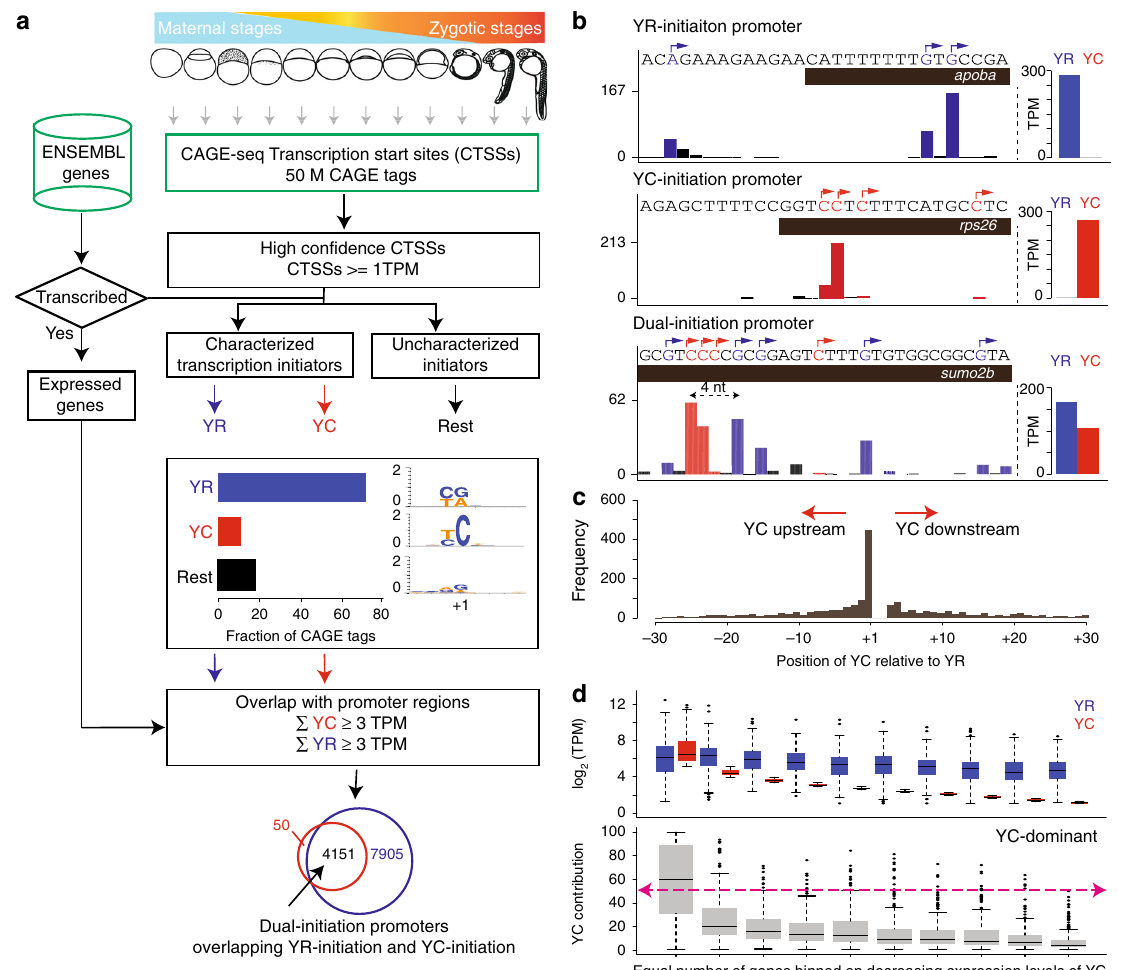
Fig. 1 Intertwined canonical initiator (YR) and non-canonical initiator YC (alias as TCT/5 ’ TOP) within the same core promoter. a A systematic pipeline for identi fi cation of canonical (YR) and non-canonical (YC) initiators in the zebra fi sh developmental promoterome. CTSSs are classi fi ed into YR and YC initiators based on CAGE transcription start sites (CTSSs). b UCSC browser views with CAGE data from prim 5 stage to illustrate examples of YR-initiation ( apoba ) and YC-initiation ( rps26 ) promoters along with a gene promoter with intertwined YR-initiations and YC-initiations ( sumo2b ). YR-initiations and YC- initiations are shown in blue and red colors respectively. Barplot on the right shows the sum of expression levels of YR-initiations and YC-initiations. Highest CTSS represents the dominant transcription start site. The distance between dominant YR and YC in sumo2b is four nucleotides. c Frequency of position of dominant YC-initiation relative to dominant YR-initiation in dual-initiation promoters. d Contribution of YC-initiation with respect to YR- initiation expression levels in prim 5 stage. The 4151 genes with dual-initiation are sorted according to YC expression levels and grouped into 10% bins. Expression levels (top) and proportion of YC-initiation to total (bottom) are shown. Red dash line indicates 50% cutoff. TPM, tags per